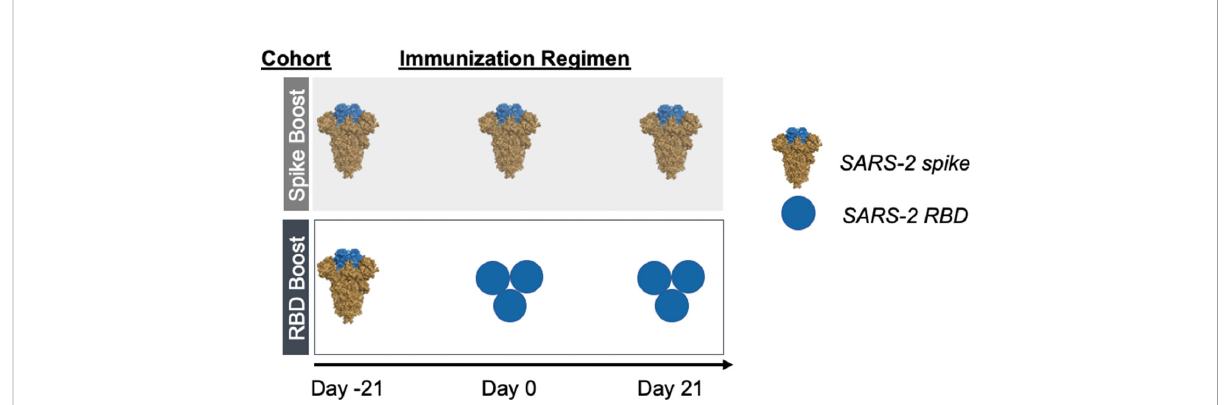
FIGURE 1 Immunization regimens. Two immunization cohorts were used for this study (n=5 mice per cohort). Mice were primed with SARS-2 2-proline- stabilized spike protein on day -21 and then boosted with either the same spike protein ( “ Spike Boost ” cohort) or a trimeric SARS-2 RBD ( “ RBD Boost ” cohort) at days 0 and